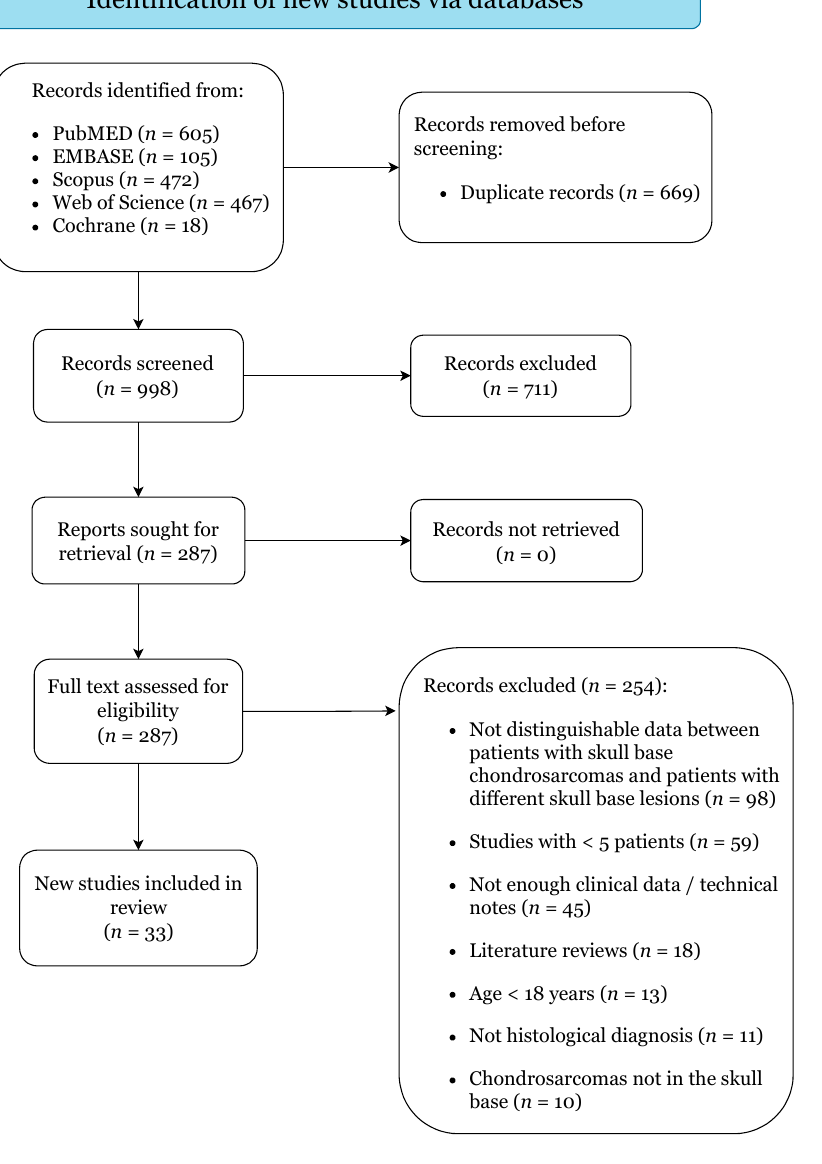
Figure 1. PRISMA 2020 Flow-Diagram.